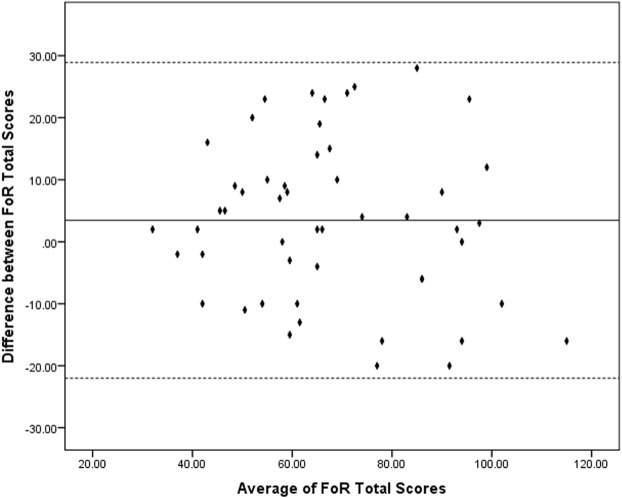
Bland-Altman plot: differences between two times completion of the Fear of Relapse (FoR) Scale by the average of the two scores. Dotted lines indicate the interval that includes 95% of differences between the first and the second assessment.